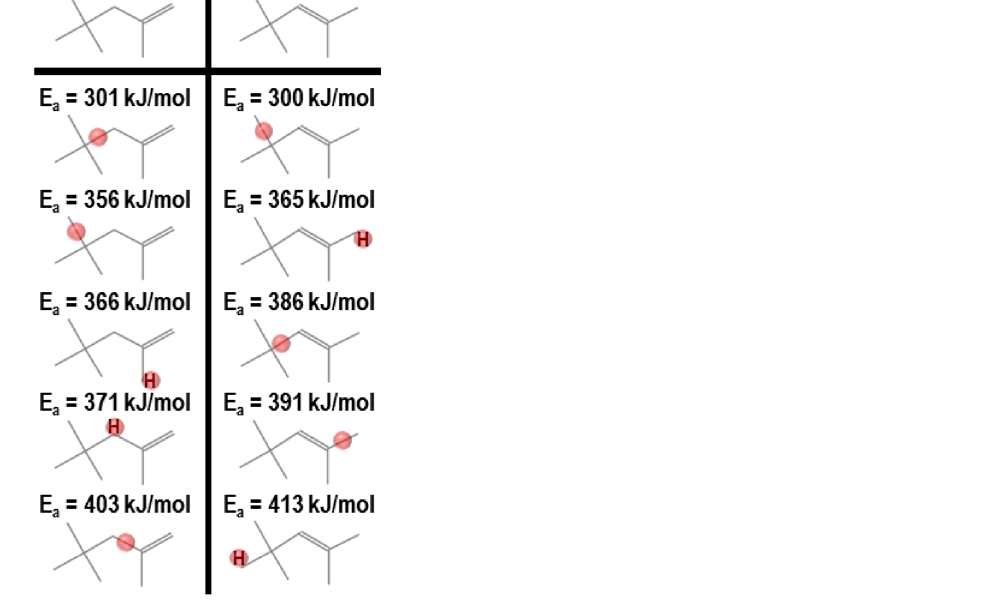
Figure 1. Diisobutylene α-, β- shown with the placement of C=C bond 27 and five weakest bond dissociation energies 29